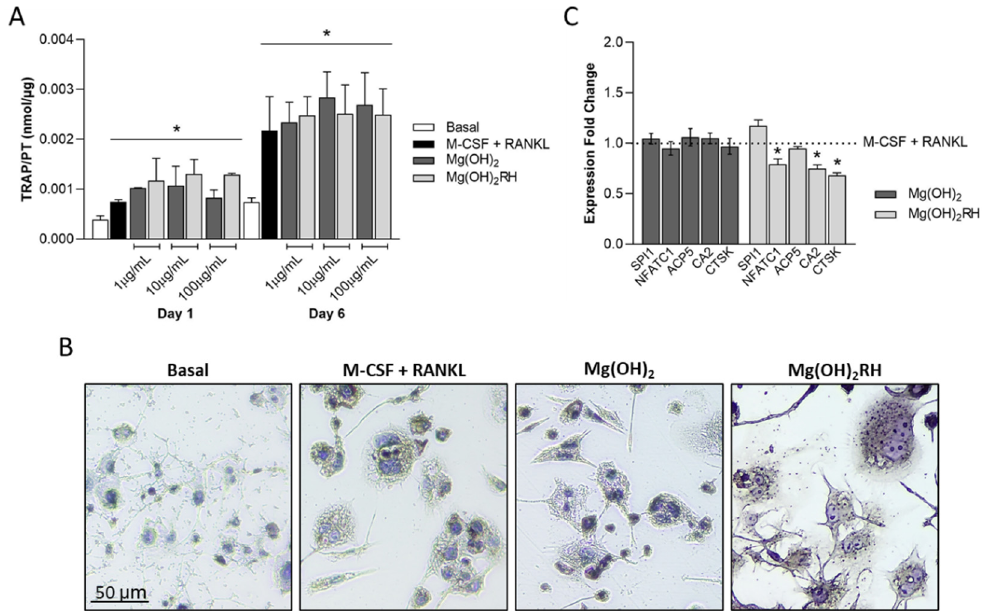
Figure 5. ( A ) — TRAP activity of THP-1-derived cells cultured in basal medium, in the presence of M-CSF and RANKL, and exposed to Mg(OH) 2 and Mg(OH) 2 RH NPs (1, 10, and 100 µg/mL) for 1 and 6 days. * Significantly different from the cultures grown in basal medium . ( B )—histochemical staining of TRAP in control cultures and exposed to the NPs (10 µg/mL) for 6 days; ( C )—expression of osteoclastic genes in cultures treated with the NPs (10 µg/mL) for 1 day. * Significantly different from the cultures grown in the presence of M-CSF and RANKL.